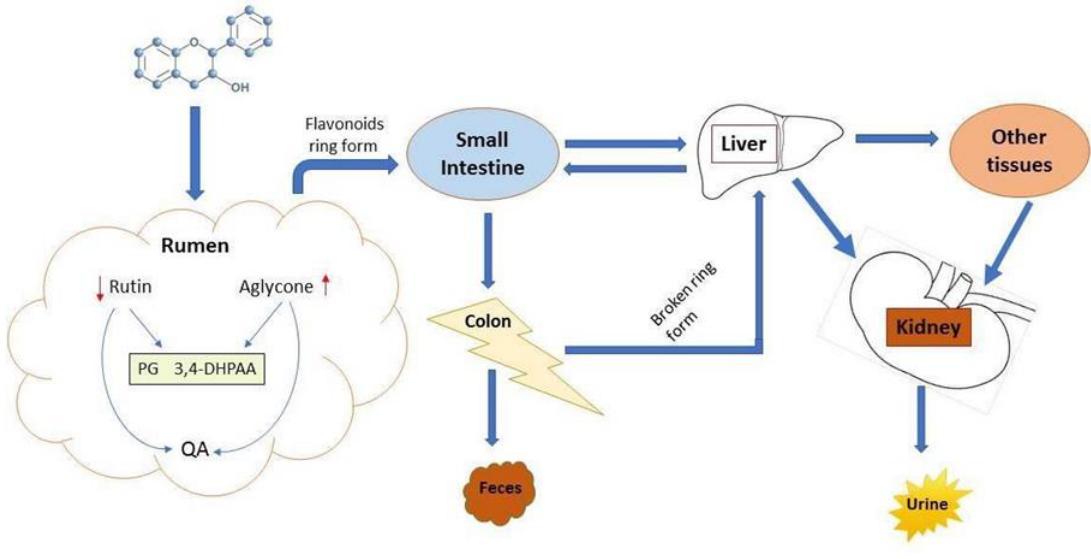
Figure 3. Putative mechanism of flavonoid metabolism and excretion in ruminants.